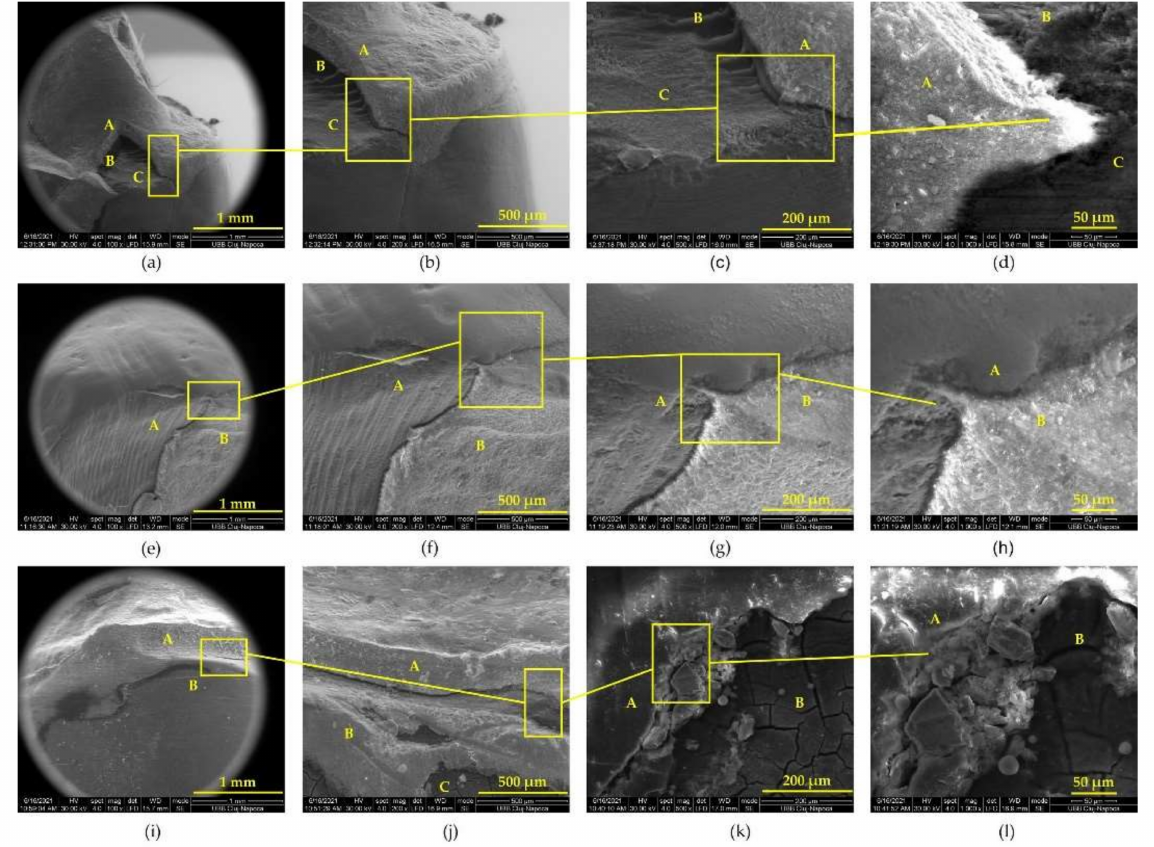
Figure 6. SEM examination of fracture areas after mechanical pull-out test: ( a ) SEM image of the veneer fracture zone: ceramic material (A), residual cement (B), tooth dentin (C) × 100; ( b ) SEM image of the veneer fracture zone: ceramic material (A), residual cement (B), tooth dentin (C) × 200; ( c ) SEM image of the veneer fracture zone: ceramic material (A), residual adhesive cement (B), tooth dentin (C) × 500; ( d ) SEM image of the veneer fracture zone: ceramic material (A), residual adhesive cement (B), tooth dentin (C) × 1000; ( e ) SEM view of the inlay cavity after debonding: prepared marginal dentin (A), residual adhesive cement (B) × 100; ( f ) SEM view of the inlay cavity after debonding: prepared marginal dentin (A), residual adhesive cement (B) × 200; ( g ) SEM view of the inlay